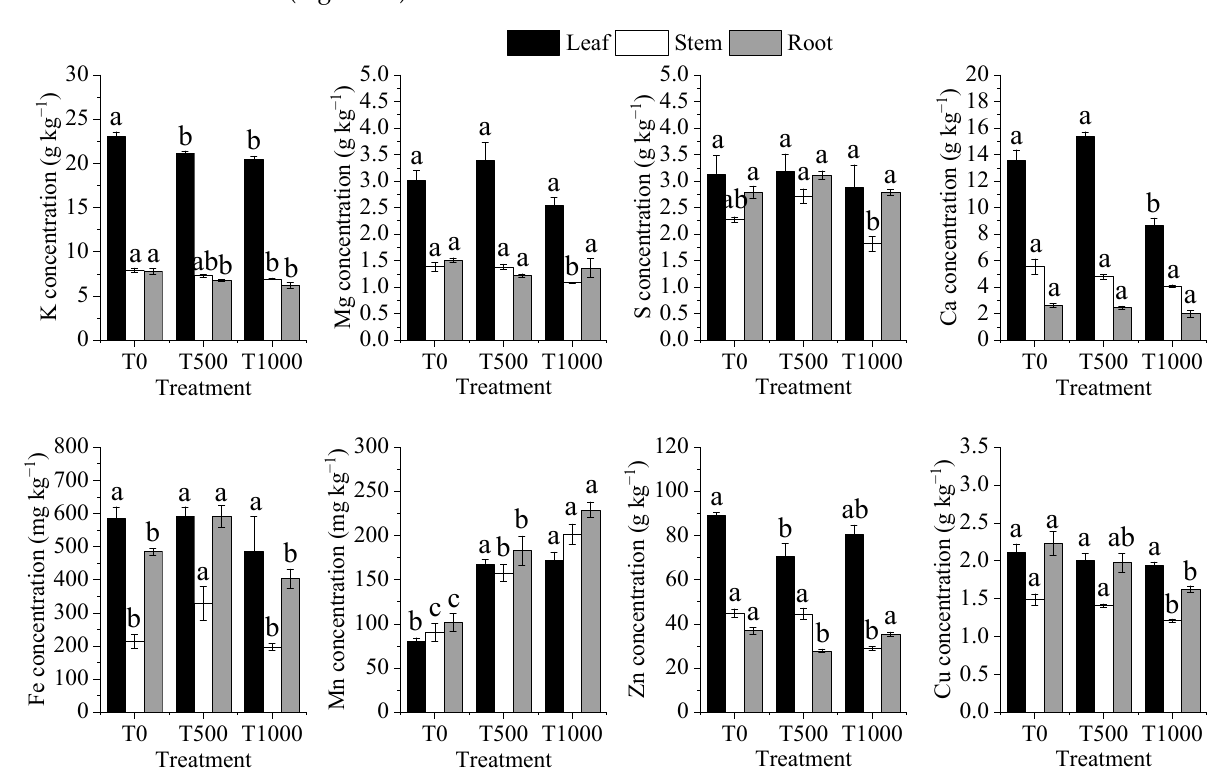
Figure 2. The element concentration in R. chinensis under different treatments. Each value represents the mean of three replicates ± SE. Different letters indicate significant difference between the treatments derived from the same organ ( p < 0.05).